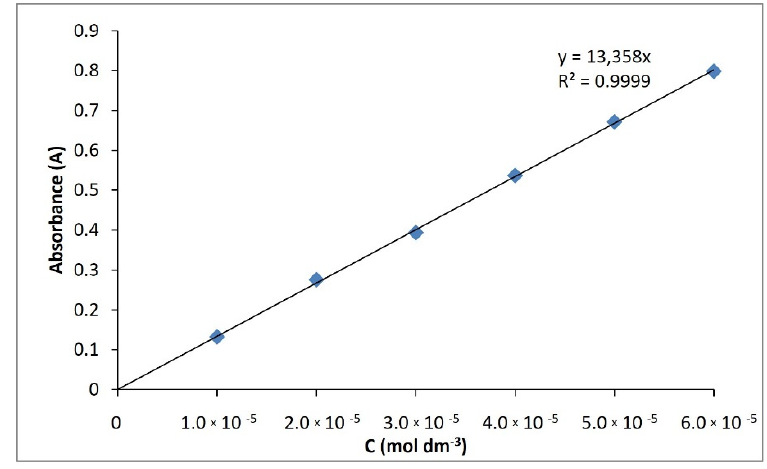
Figure 15. Calibration curve of compound II .